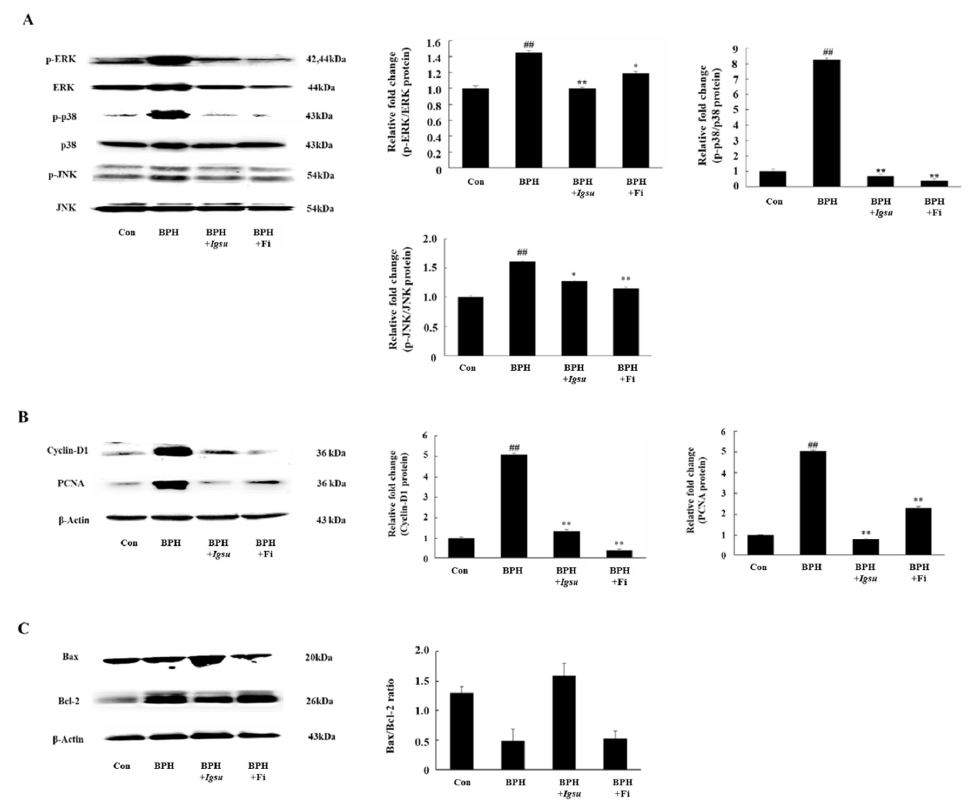
Figure 7. Expression of mitogen-activated protein kinase (MAPK)-, cell proliferation-, and apoptosis- related factors in prostate tissue following administration of Igsu in BPH. ( A ) Expression of MAPK signaling pathway mediators in prostate tissue. ( B ) Expression of cell proliferation-related proteins, proliferating cell nuclear antigen (PCNA) and cyclin D1, in prostate tissues. ( C ) Expressions of apoptosis-related proteins and B-cell lymphoma 2 (Bcl-2) X-associated (Bax)/Bcl-2 ratio in prostate tissues. Con, normal control group; BPH, TP (3 mg/kg/day)/corn oil injection; BPH + Igsu , Igsu -treated BPH group; BPH + Fi, Fi-treated BPH group. Data are presented as the mean ± SEM ( n = 8). Significant differences at ## p < 0.01 compared with the Con group. Significant differences at * p < 0.05, ** p < 0.01 compared with the BPH group.